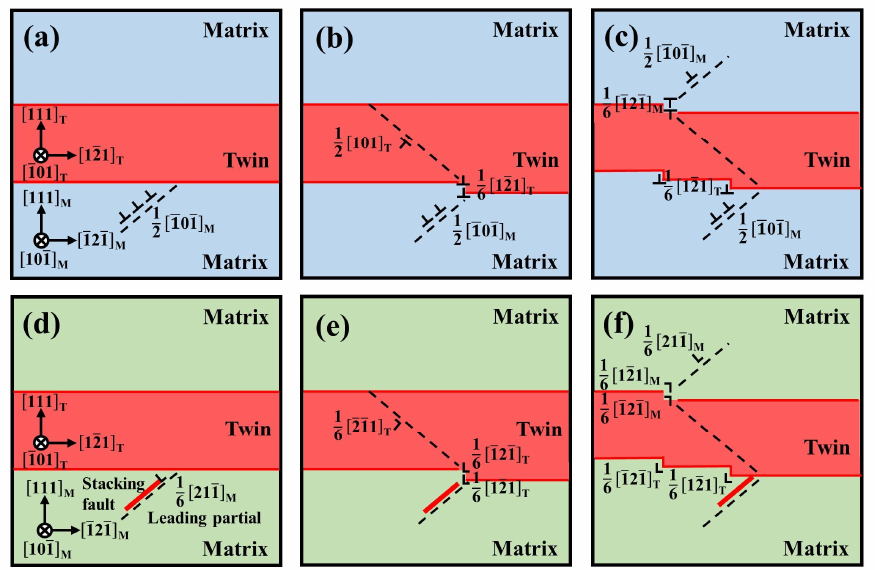
Figure 11. Possible mechanisms of interaction between different dislocations and twin boundaries in FCC alloys. ( a – c ) perfect dislocation; ( d – f ) leading partial dislocation ahead of the stacking fault in extended